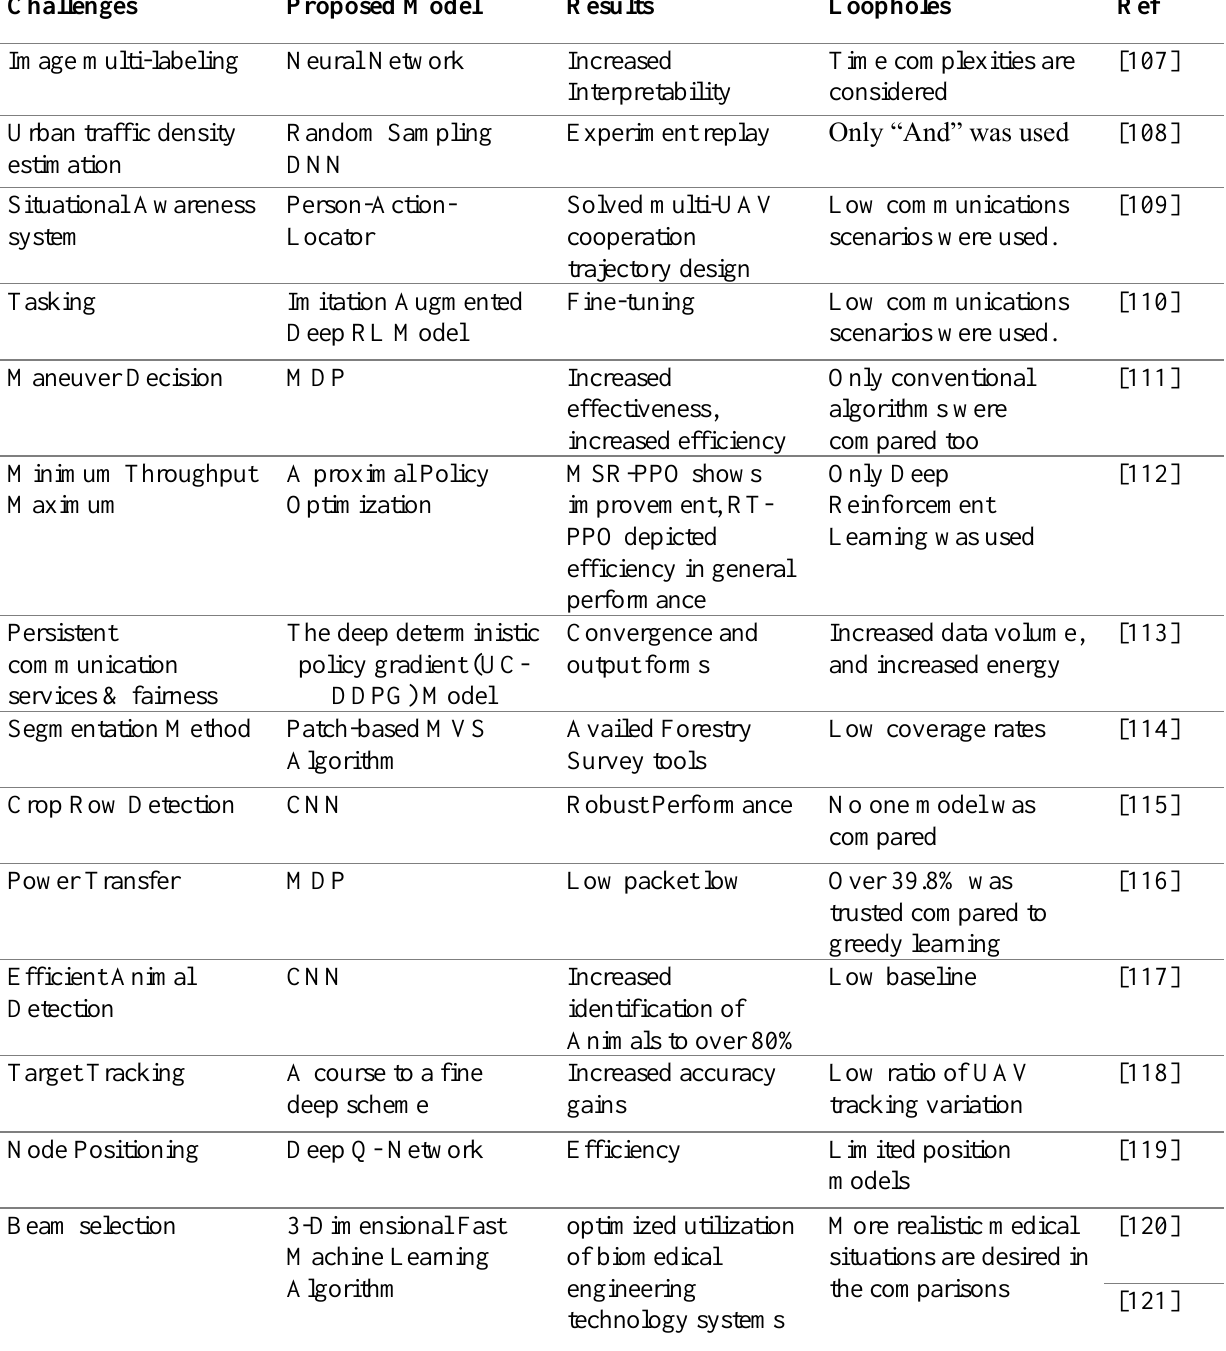
Table 5. State-of-the-art challenge trends, and loopholes of